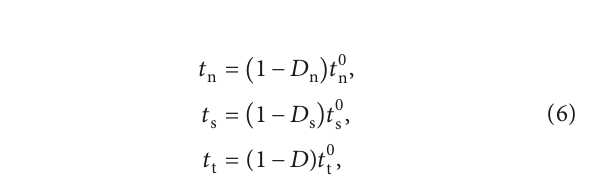
Figure 14: Typical traction-separation